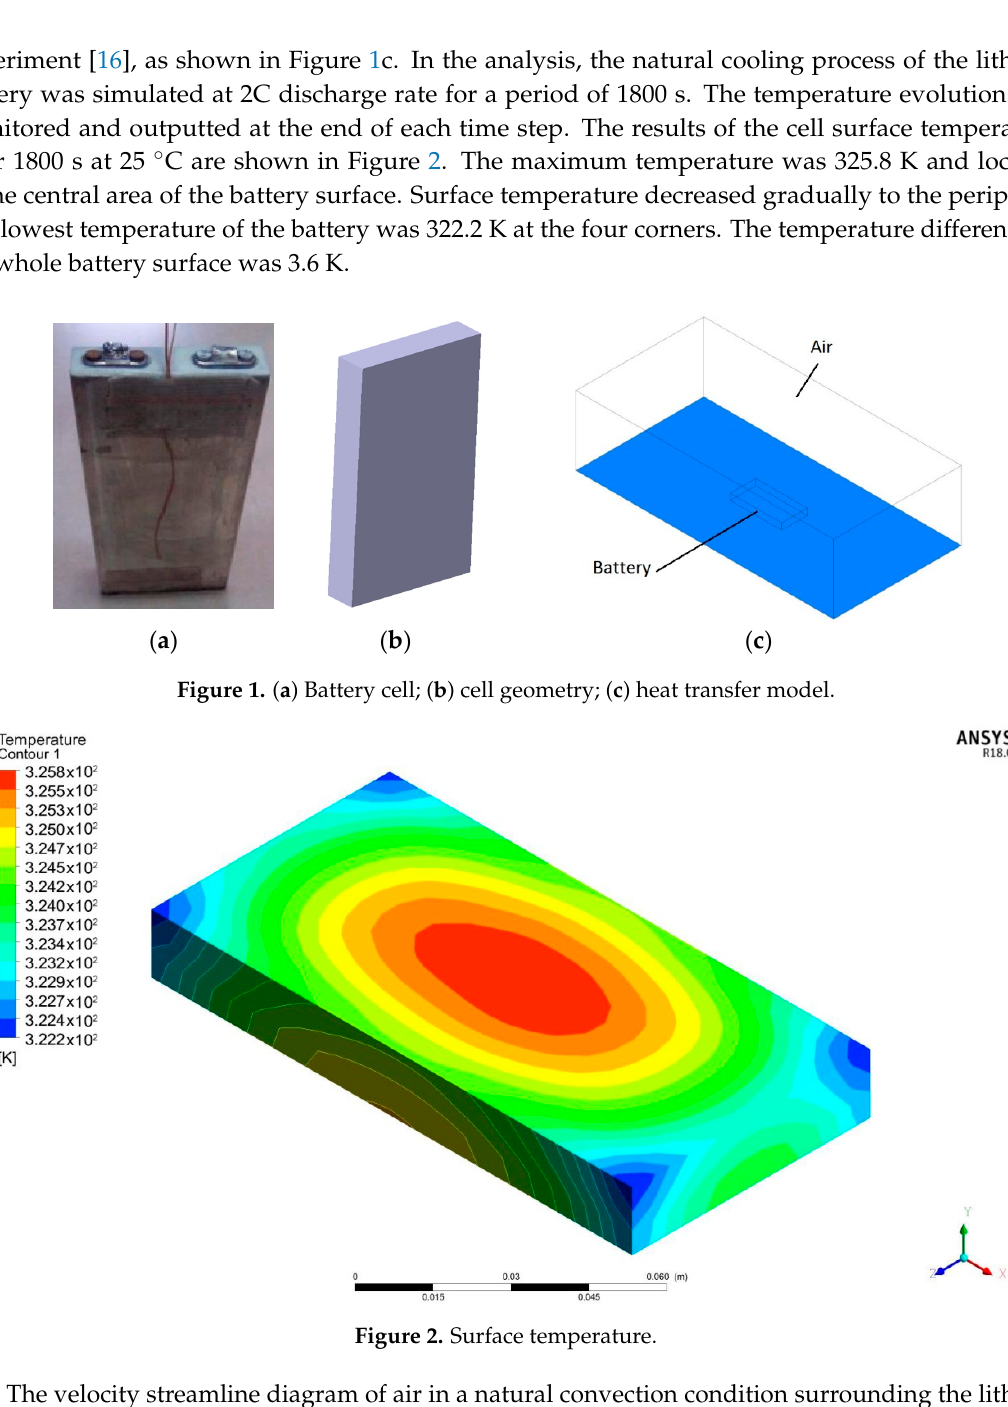
Table 2. Thermophysical parameters [25]. Name